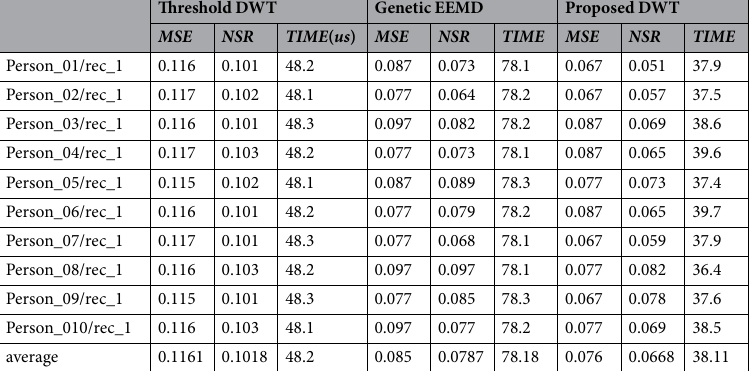
can be tolerated, is it true that the larger the order number of the vanishing moment, the more concentrated the energy generated when the signal is decomposed by the wavelet? How can we realize the precise filtering of ECG signal by wavelet transform and keep the singular point in the signal? In this paper, a quantitative analysis was performed to study the correlation between the vanishing moment and frequency characteristics of the wavelet, an optimal wavelet base function was selected based on the amplitude frequency characteristics of ECG signals, and wavelet bases of different orders were used to deal with different wavelet spaces. We also found that the accurate bandpass filtering could be realized in the process of wavelet transform according to the different frequency characteristics of noise, which effectively avoided the damage to the signal during the denoising process. Experimental results showed that the proposed wavelet transform with optimized parame- ters had a remarkable effect on ECG signal denoising and has a strong practical significance, including the ECG monitoring watch developed by myself.